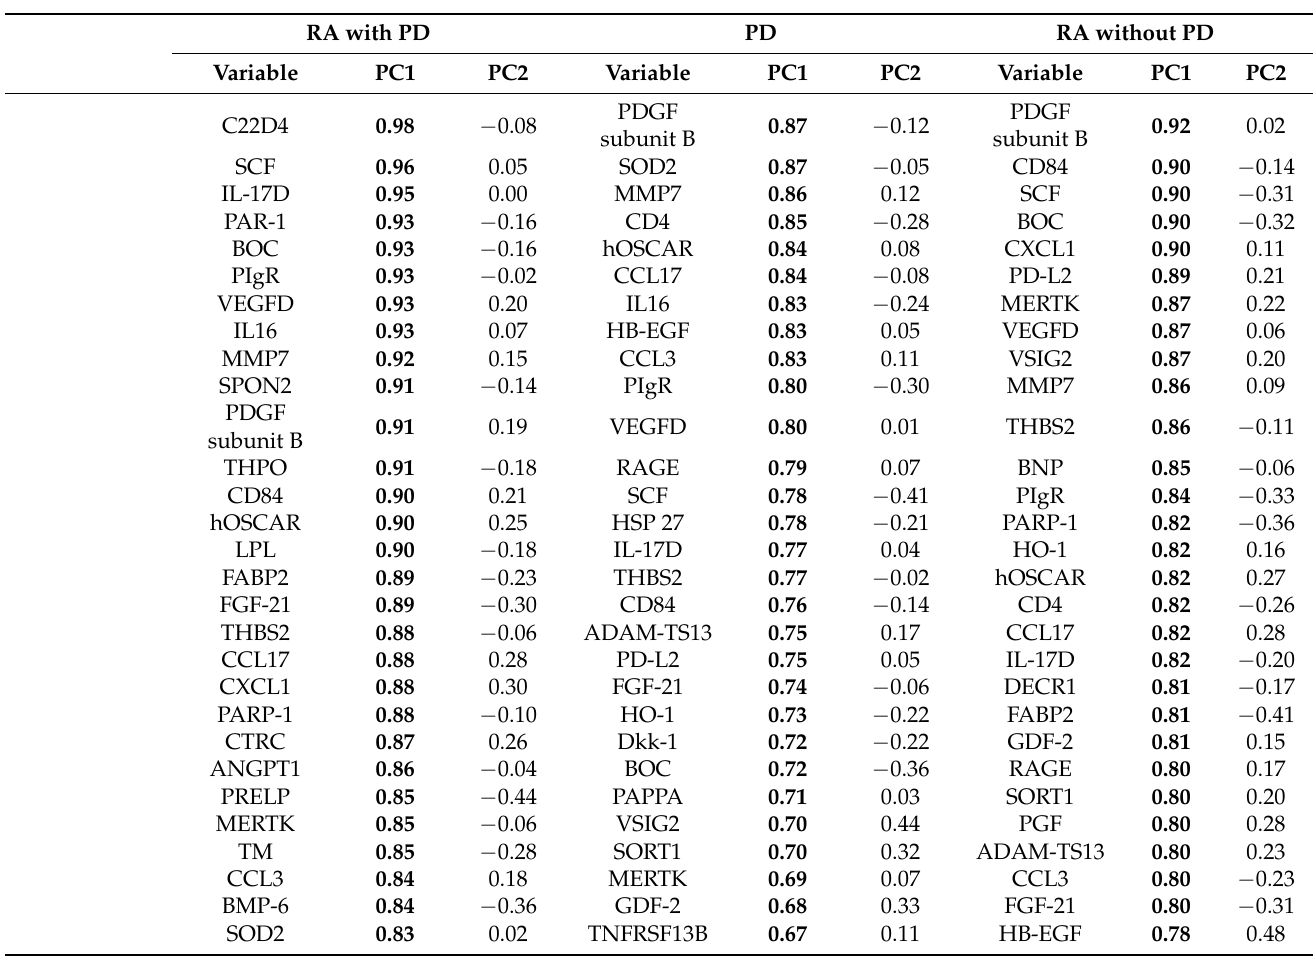
Table 3. PC loadings for disease